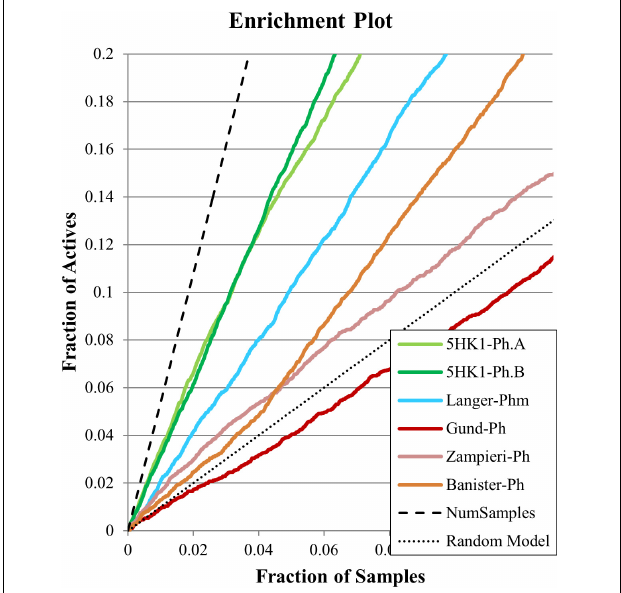
FIGURE 8 | Enrichment plots for the six evaluated pharmacophore models for the first 10% of selected samples.